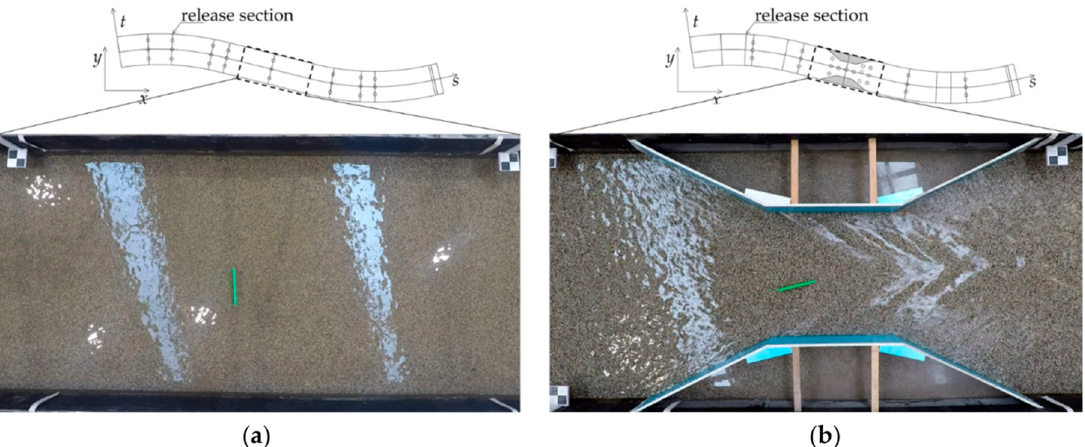
Figure 2. ( a ) S-shaped flume planar view and example of recorded frame. ( b ) S-shaped flume with narrowing and example of recorded frame. Circles in both planar views show the points of measure of the flow velocity.